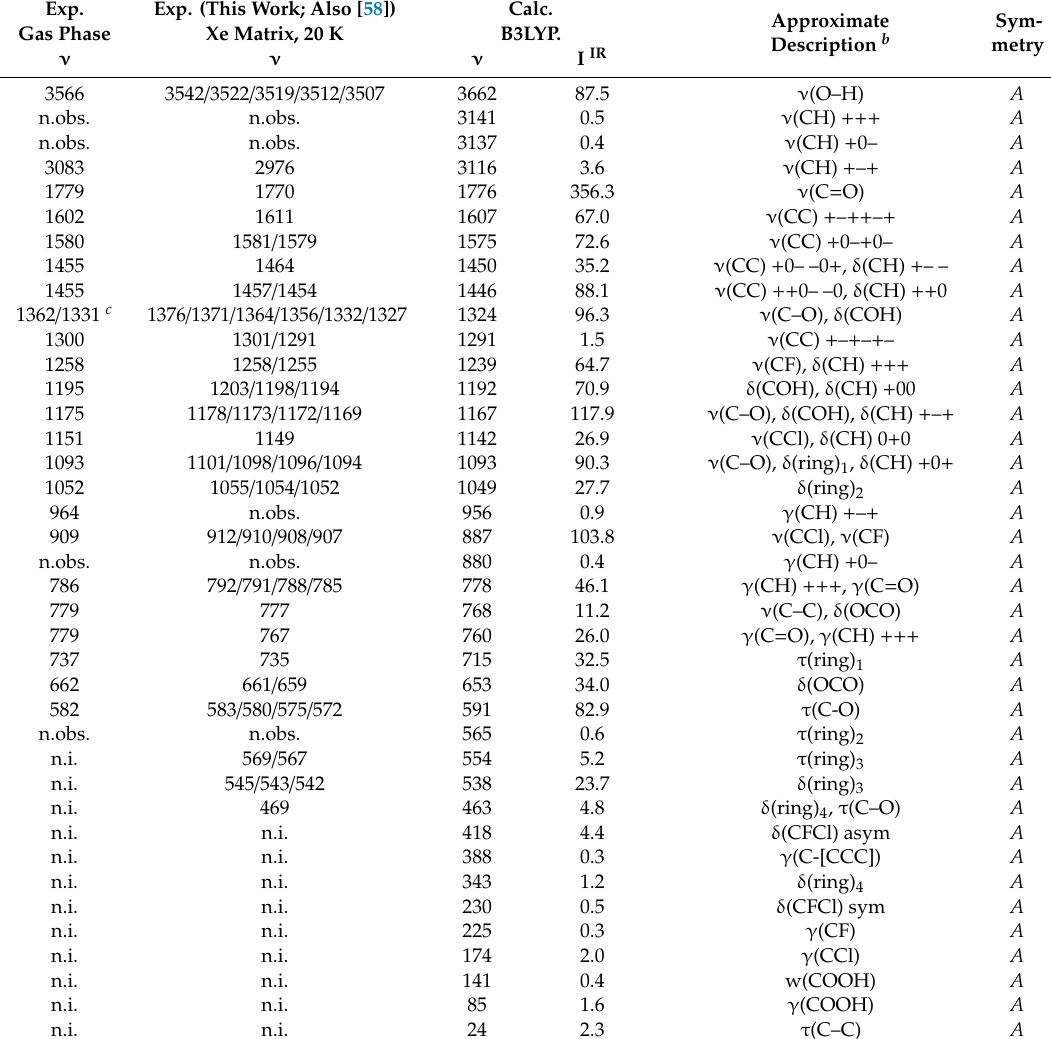
Table 6. Experimental (Exp.) and B3LYP / 6-311 ++ G(d,p) calculated (Calc.) infrared spectra of monomeric 2-chloro-6-fluorobenzoic acid, and band assignments a . Exp.